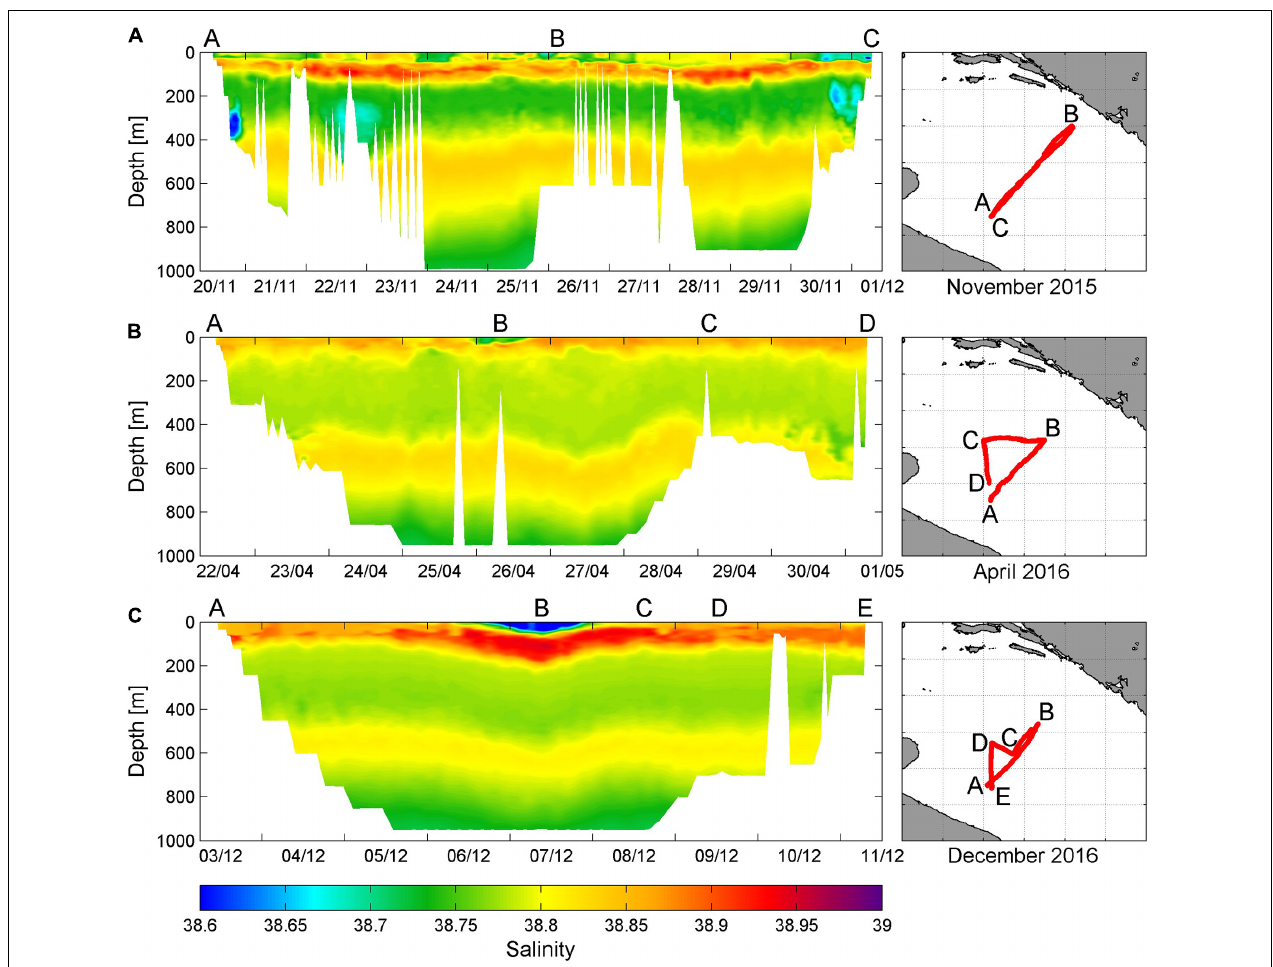
FIGURE 8 | (A) Glider salinity transect in the in the Southern Adriatic between 20 November and 1 December 2015 (left panel) and the corresponding trajectory of the glider (right panel). (B) As in panel (A) except for glider transect from 22 April to 1 May 2016. (C) As in panel (A) except for glider transect from 3 to 11 December 2016. Please note that the salinity scale for these glider transects is different than in Figure 4